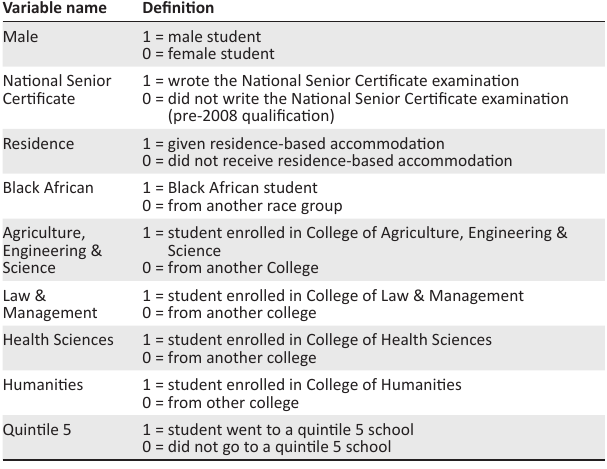
TABLE 1: Variables that were included in the